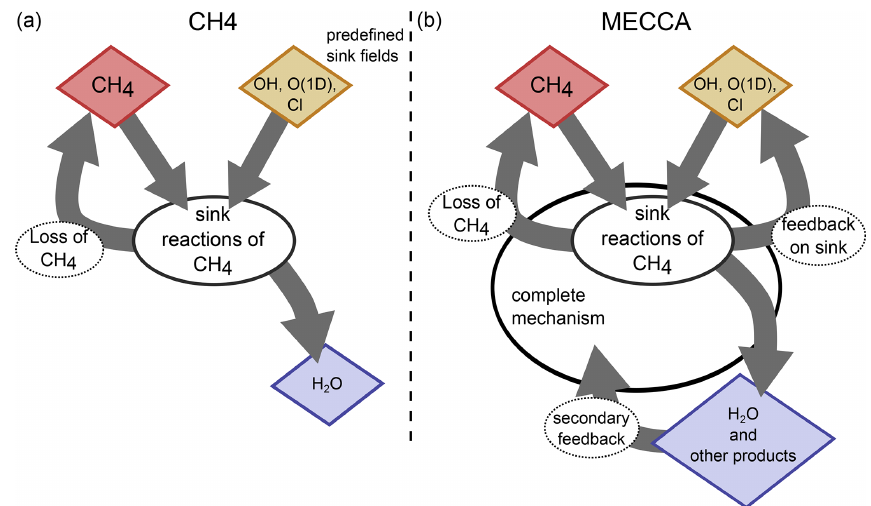
Figure 1. Sketch visualizing the concepts of parameterizing CH 4 sink reactions in the MESSy submodels CH4 (a) and MECCA (b) . The red species is the core species CH 4 . The chemical mechanism in CH4 is reduced to the sink reactions of CH 4 and optionally includes the feedback to H 2 O (blue) only. In MECCA a complete chemical mechanism is included, which among others feeds back onto H 2 O and other products of the CH 4 sink reactions, including the reaction partners (educts) of CH 4 . The reaction partners (yellow) in the CH4 submodel are prescribed and not changed by the CH4 submodel.